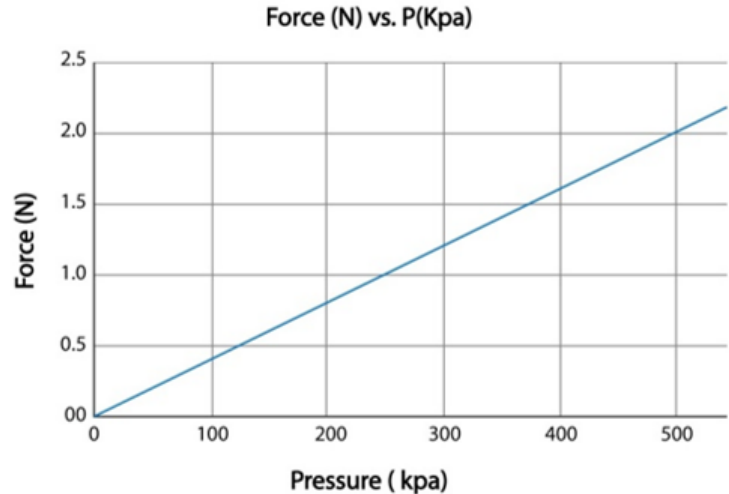
Figure 8. Impact of varies pressure on the output force for actuator.